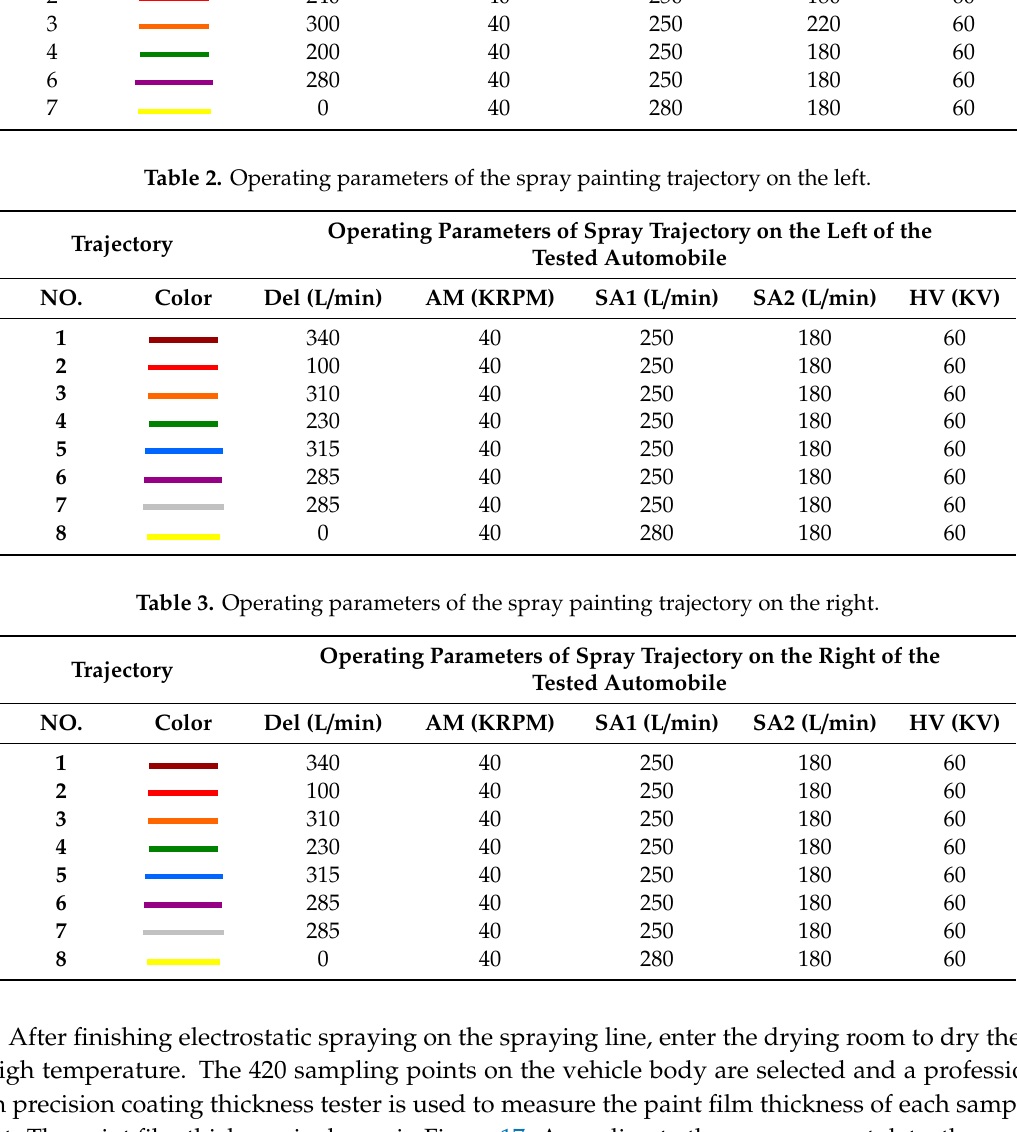
Table 1. Operating parameters of the spray painting trajectory on the roof and tail.